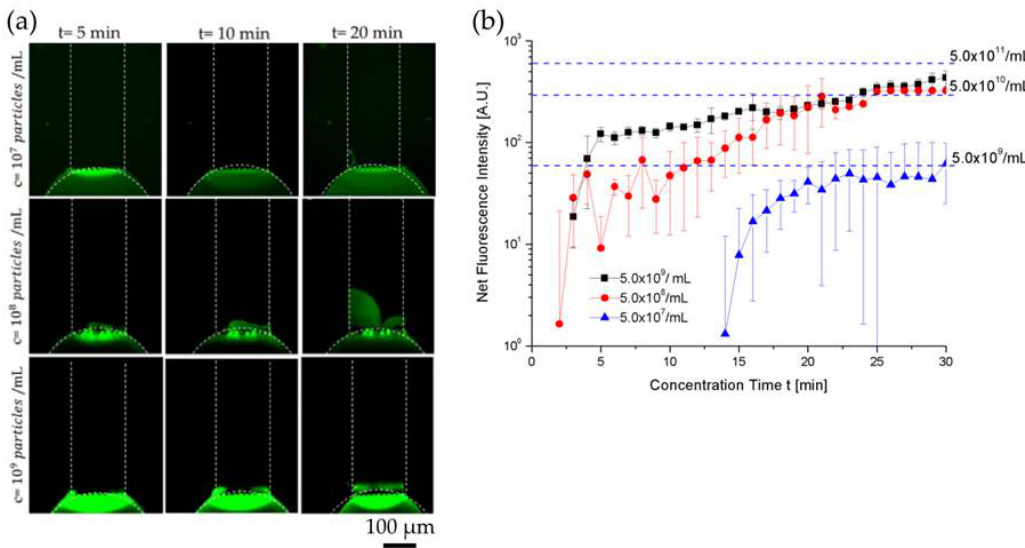
Figure 3. Characterization of extracellular vesicle concentration enhancement for 5.0 × 10 7 particles/1 mL (LOD), 5.0 × 10 8 particles/1 mL, and 5.0 × 10 9 particles/1 mL at 45 V/cm on a SuperEpoxy 3 microarray slide without antibody. ( a ) bright fluorescent plug inside the channel indicating EVs near the conductive polymer membrane—size continued to increase as a function of concentration time. ( b ) Fluorescence signal intensity curves of 5.0 × 10 7 particles/1 mL (LOD), 5.0 × 10 8 particles/1 mL, and 5.0 × 10 9 particles/1 mL. EV concentrations of 5.0 × 10 7 particles/1